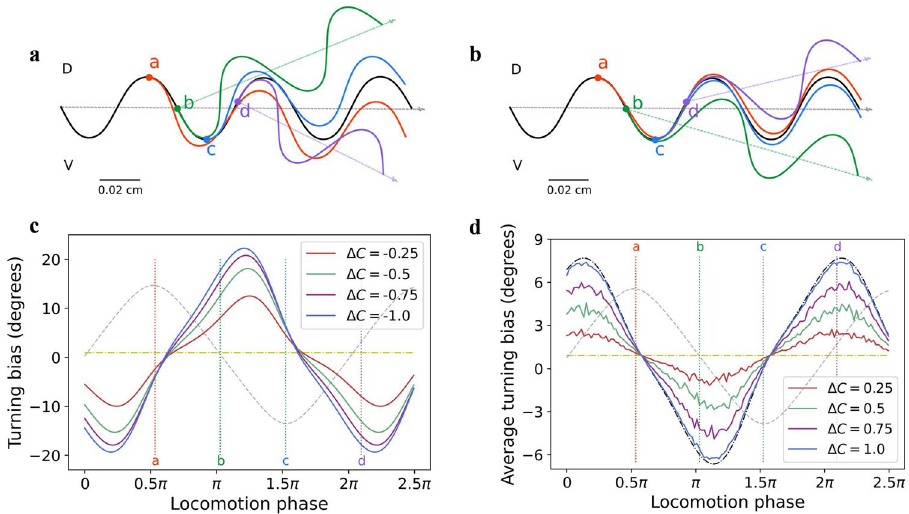
Figure 3. Steering responses of the model elegans elicited by up-/down-steps. ( a ), ( b ) Changes in locomotion track caused by down-steps ( a ) or up-steps ( b ). The black curves represent the tracks without stimuli, and the four colored curves respectively represent the tracks after applying an up-/down-step at the four phases of the corresponding colors. ( c ), ( d ) Steering response vs. locomotion phase at which a down-step ( c ) or an up-step ( d ) was applied. The four colored dotted lines represent the positions of four phases in ( a ) and ( b ). The gray dashed lines represent the shape of locomotion in all the phases. The yellow dash-dot lines represent the turning bias when ASEL was not activated or without stimulus. The black dash-dot line in ( d ) represents the turning bias when ASEL was